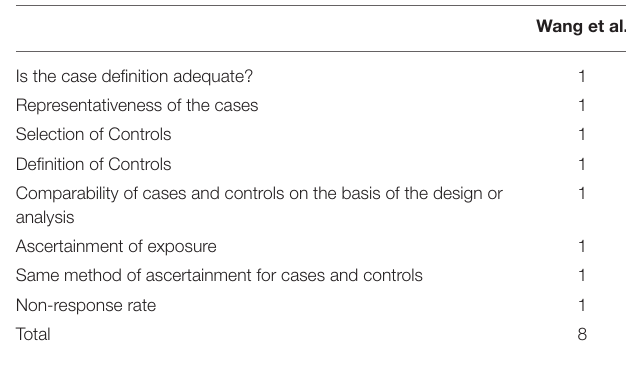
TABLE 2 | Newcastle-ottawa quality